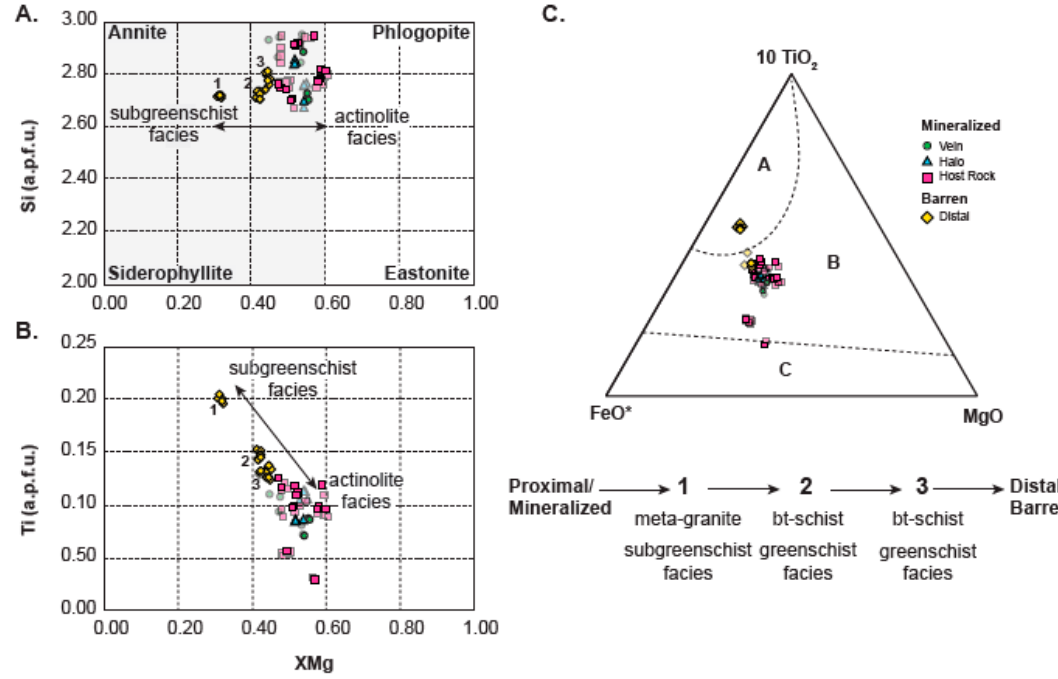
Figure 4. ( A ) Si vs. X Mg binary diagram showing the Mg-rich biotitic compositions of all four biotite populations with relatively elevated di-octahedral mica proportions. Note, barren biotite reveal